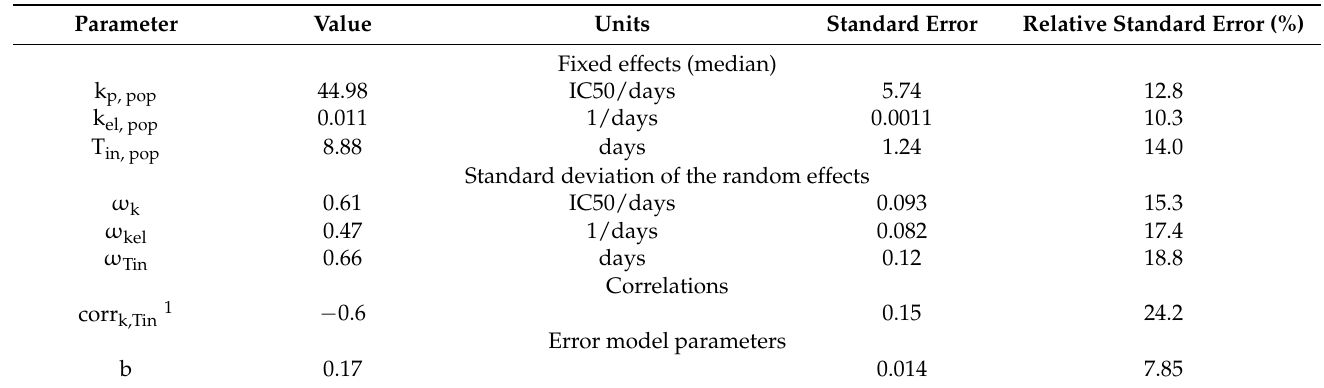
Table 1. Parameter values for fitted nAb kinetics model with standard errors (SE) and relative standard error